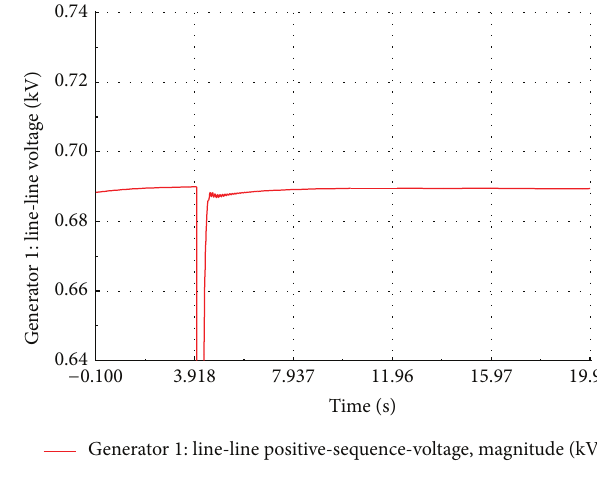
Figure 12: Simulated voltage dips at FSWEG1 busbar.